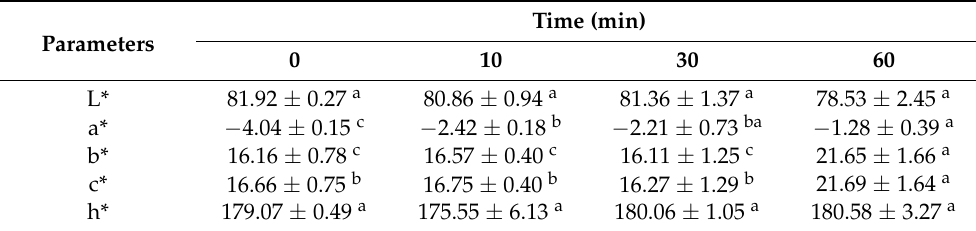
Table 2. The colorimetric parameters in the slices of chicken-manure-fertilized eggplant exposed to room temperature for different times.